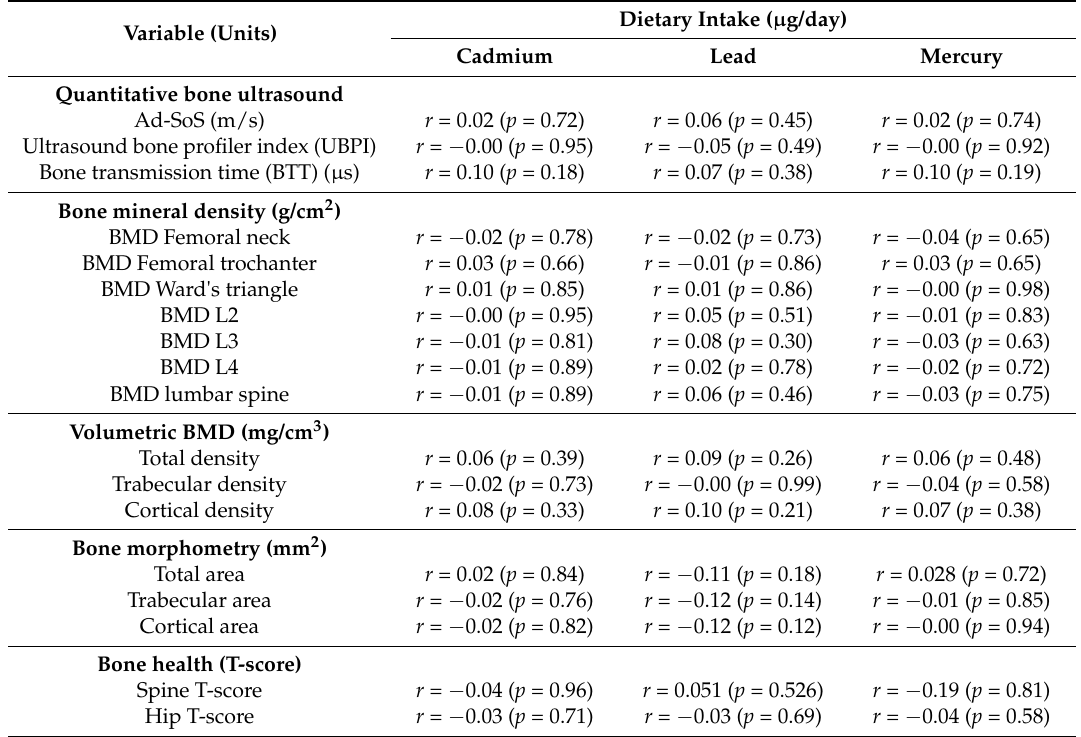
Table 8. Partial correlation results (dietary heavy metals and bone